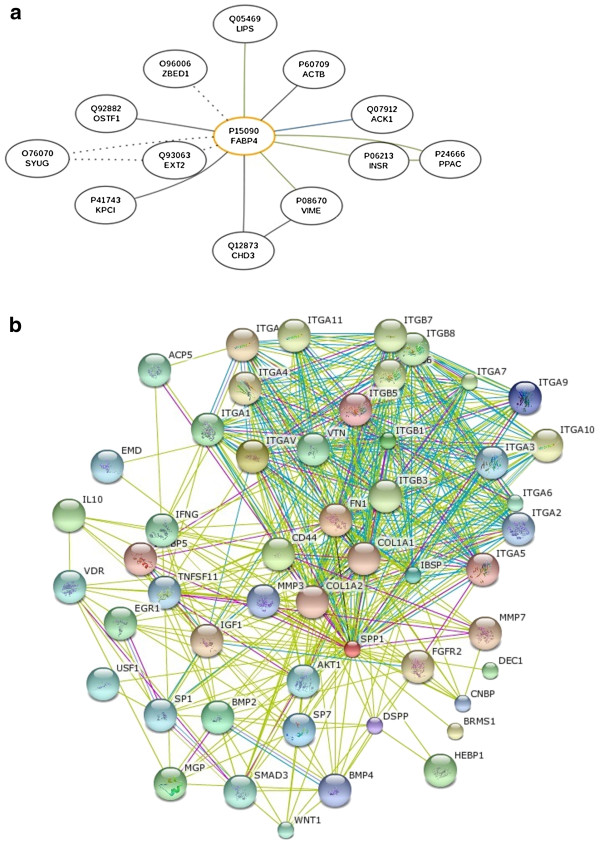
Interaction networks including FABP4 or SPP1. (a) The network that involved FABP4 based on HitPredict database, with the green lines indicating high-confidence, small-scale binary; the blue lines indicating high-confidence, small-scale–derived; the black lines indicating high-confidence, high-throughput; and the dashed black lines indicating spurious small-scale or high-throughput. (b) The network that involved SPP1 based on the STRING database.